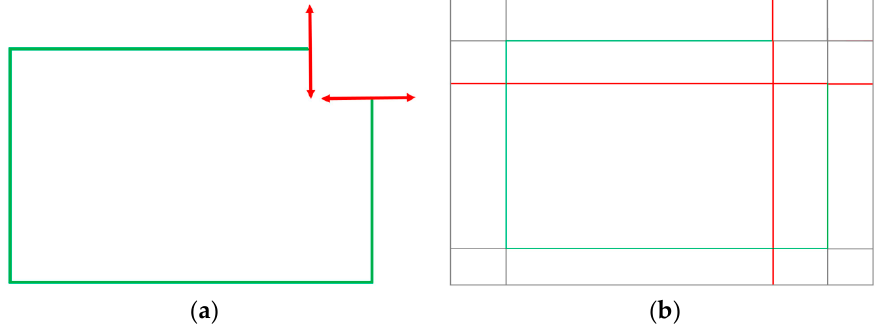
Figure 4. Example of cell complex construction: ( a ) detected and ‘pending’ walls and ( b ) induced cell complex. cell